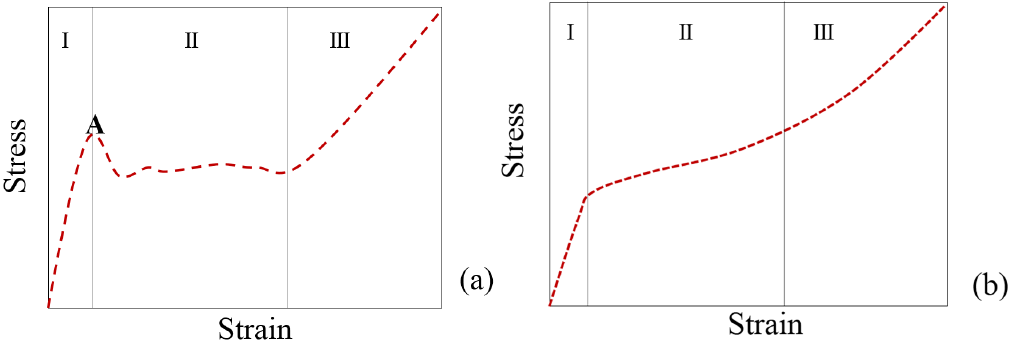
Figure 6. Representative quasi-static compressive stress-strain graphs ( a , b ) of metal matrix syntactic foams showing the linear elastic region (I), plateau region (II) and the densification strain (III).